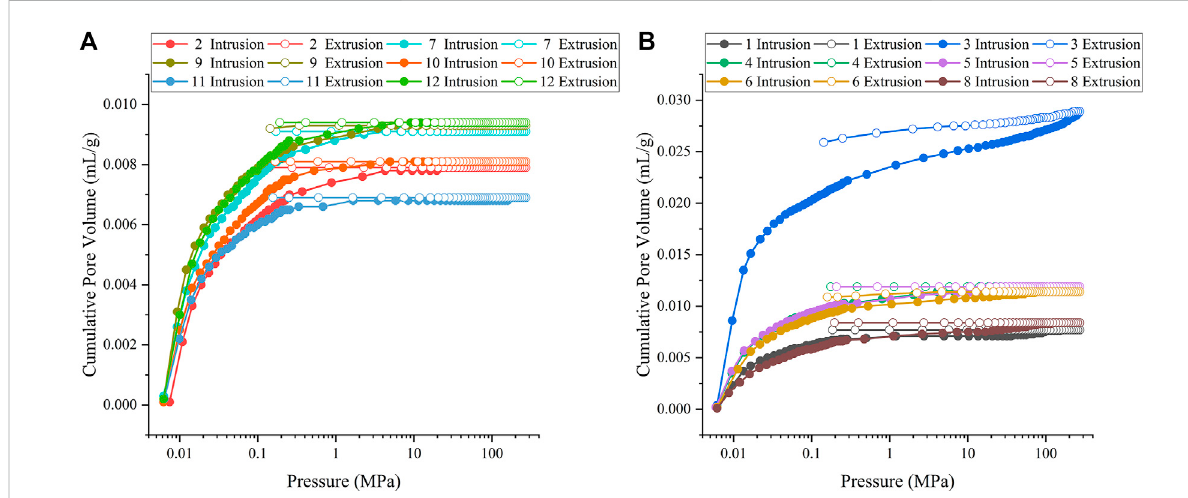
FIGURE 3 Mercury intrusion/extrusion curves of the Taiyuan Formation shales.